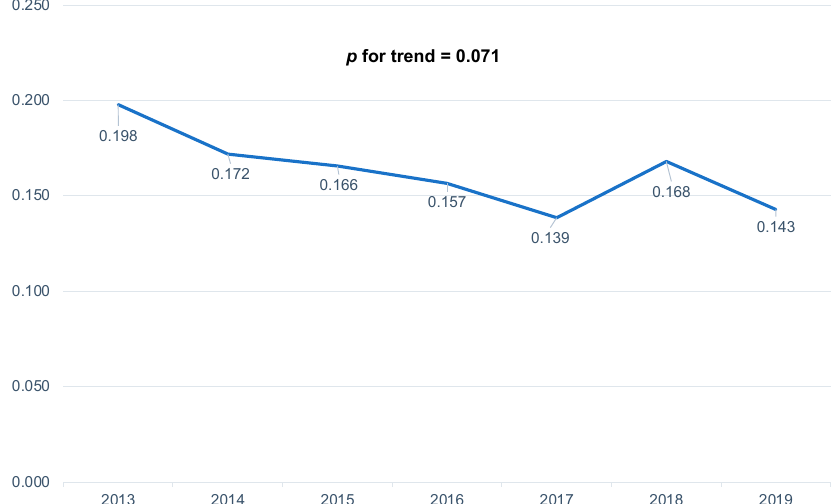
Figure 2. Age-standardized incidences of traumatic out-of-hospital cardiac arrests following traffic collisions from 2013–2019.